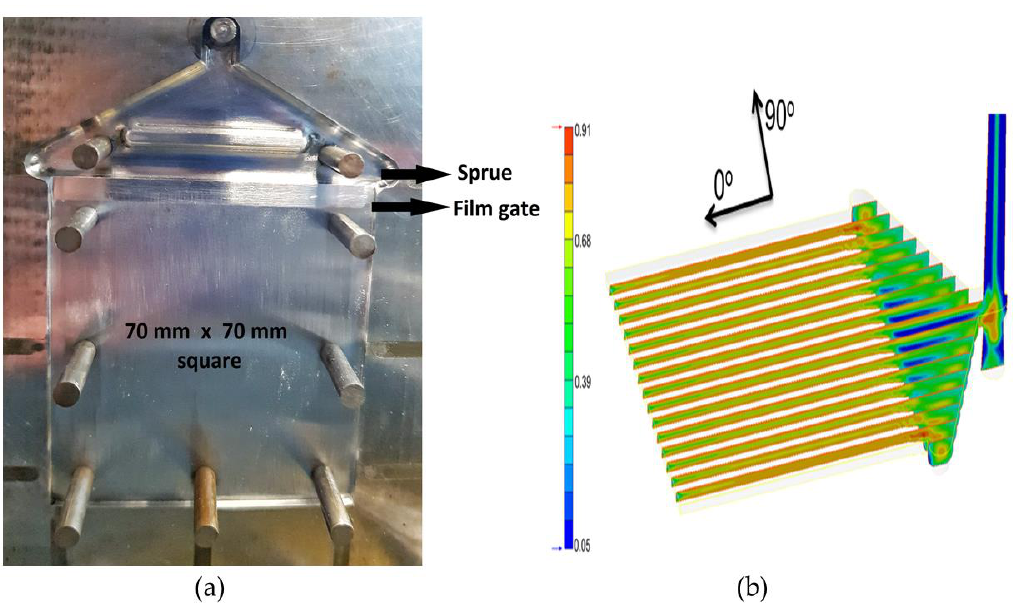
Figure 3. ( a ) Square mold, and ( b ) Flow simulation using Moldex ® 3 D with scale bare depicting orientation factor.